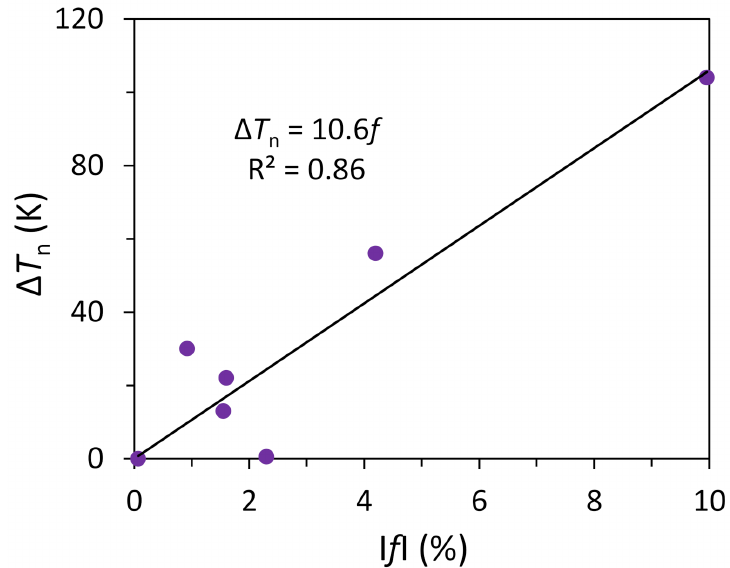
Figure 24. Nucleation undercooling (from experiments) v.s. absolute value of lattice misfit. Nu- cleation undercooling is derived from experimental results on solidification of droplets embedded in matrix from the literature [25,28,31,71–74]. ∆ T n is plotted as a function of misfit ( f ) or residual misfit ( f r ). It shows that ∆ T n is a unique linear function of lattice misfit | f |. The linear fitting of the experimental data suggests that ∆ T n = 10.6| f | with R 2 = 0.86.